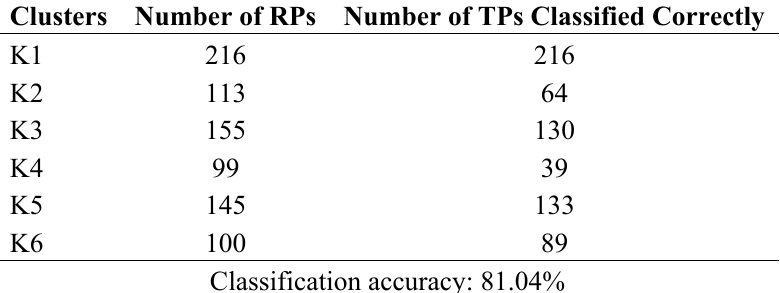
Table 2. Coarse Positioning performance of K-Means method.